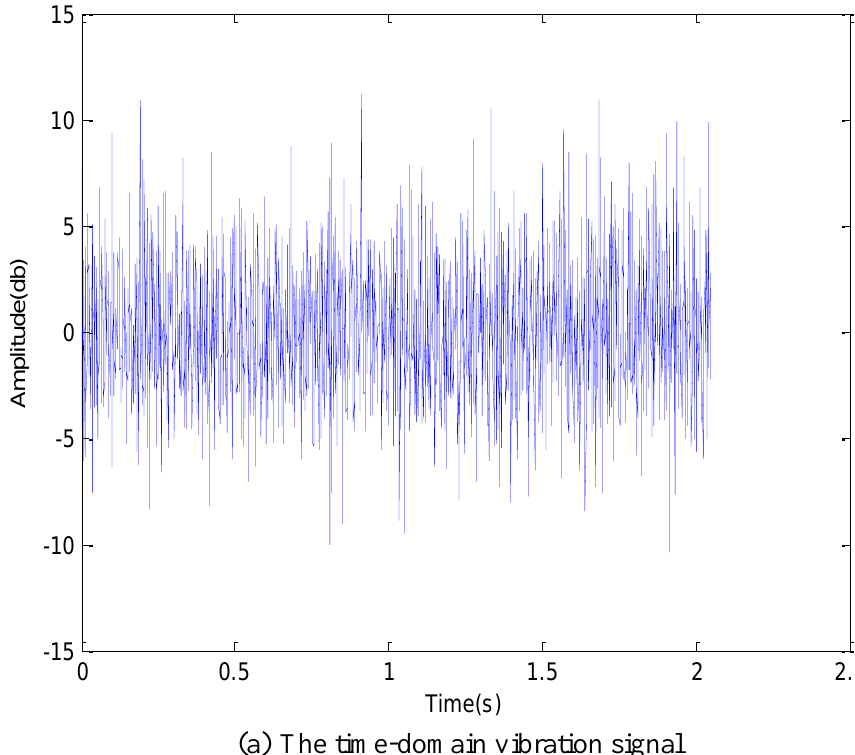
Figure 10. Vibration signals in time-domain and